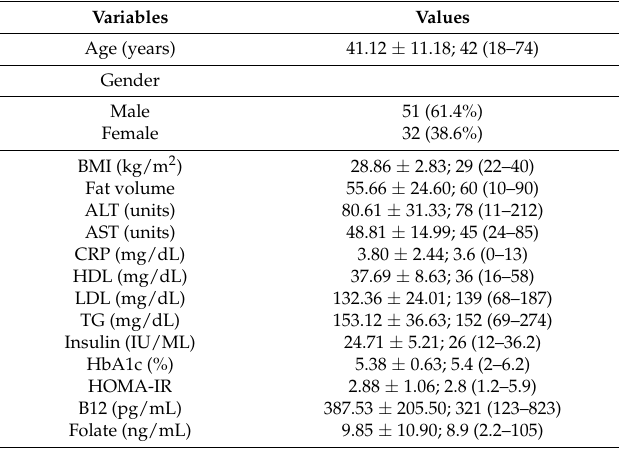
Table 1. Descriptive statistics of the population